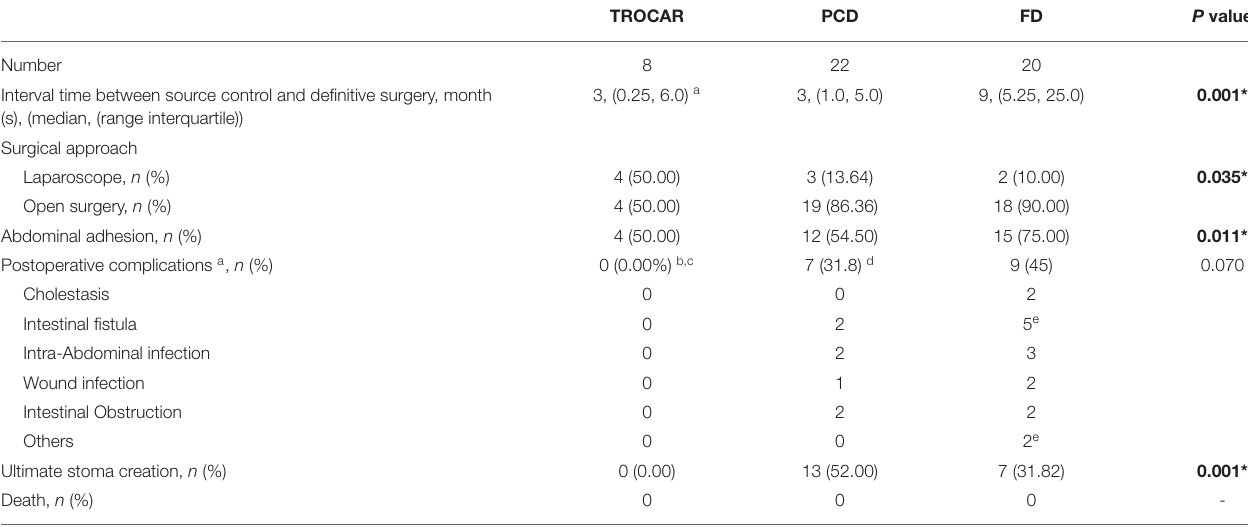
TROCAR PCD FD P value 3, (0.25, 6.0) a 3, (1.0, 5.0)